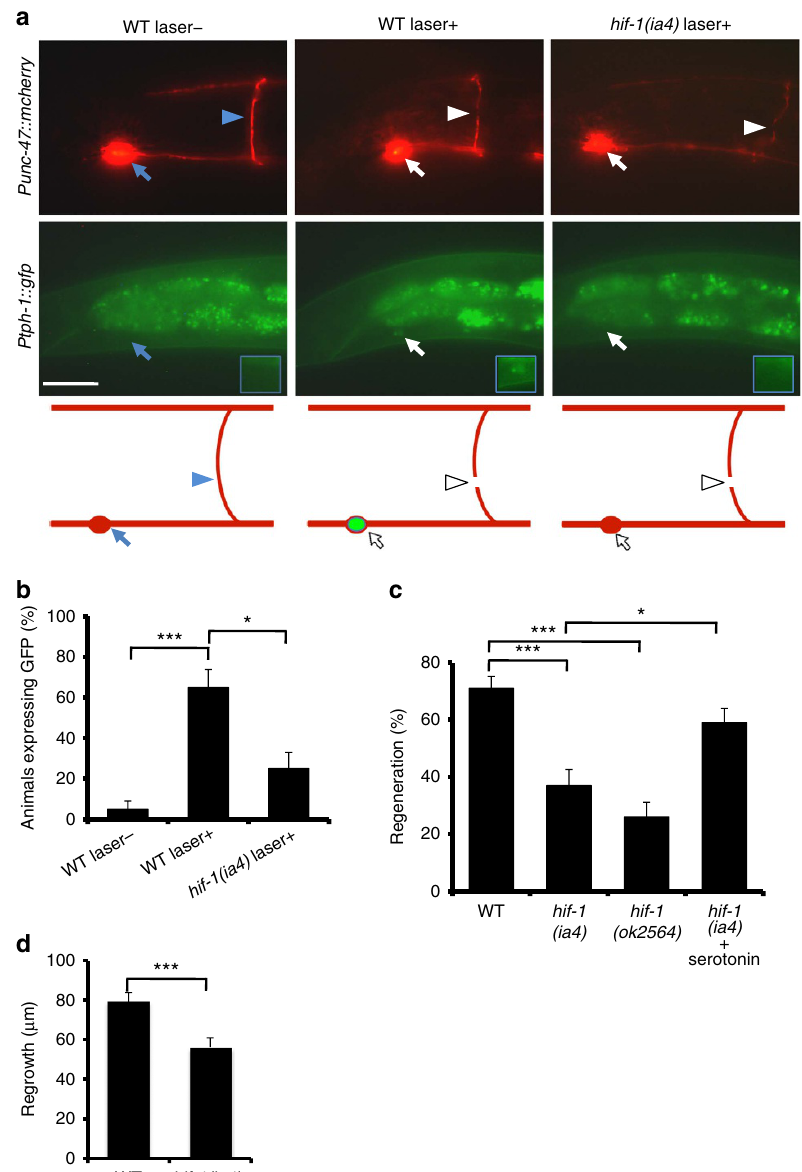
Figure 2 | HIF-1 positively regulates axon regeneration. ( a ) Induction of Ptph-1::gfp expression in D-type motor neurons by laser surgery. Expression of fluorescent proteins in D-type motor neurons 30min after laser surgery is shown. A schematic representation of D-type motor neurons is shown on the bottom. Arrowheads and arrows indicate axons and cell bodies of D-type neurons with (white) or without (blue) laser surgery, respectively. D-type neurons are visualized by mCherry under control of the unc-47 promoter. Cell bodies of D-type neurons are magnified (blue boxes). Scale bar ¼ 20 m m. ( b ) Percentages of animals expressing tph-1 . Induction of Ptph-1::gfp expression in D-type motor neurons with ( þ ) or without ( (cid:2) ) laser surgery was assayed as described in Methods section. Twenty neurons were examined for each condition. Error bars indicate 95% CI. *** P o 0.001; * P o 0.05 (Fisher’s exact test, two-tailed, n ¼ 20). ( c ) Regeneration of D-type motor neurons. Percentages of axons that initiated regeneration 24h after laser surgery are shown. Error bars indicate 95% CI. *** P o 0.001; * P o 0.05 (Fisher’s exact test, two-tailed, n Z 50). ( d ) Regeneration of PLM sensory motor neurons. Lengths of PLM regrowth at 24h after laser surgery are shown. Error bars indicate s.e.m. *** P o 0.001 ( n Z 30; unpaired t -test, two-tailed, unequal variances). CI, confidence